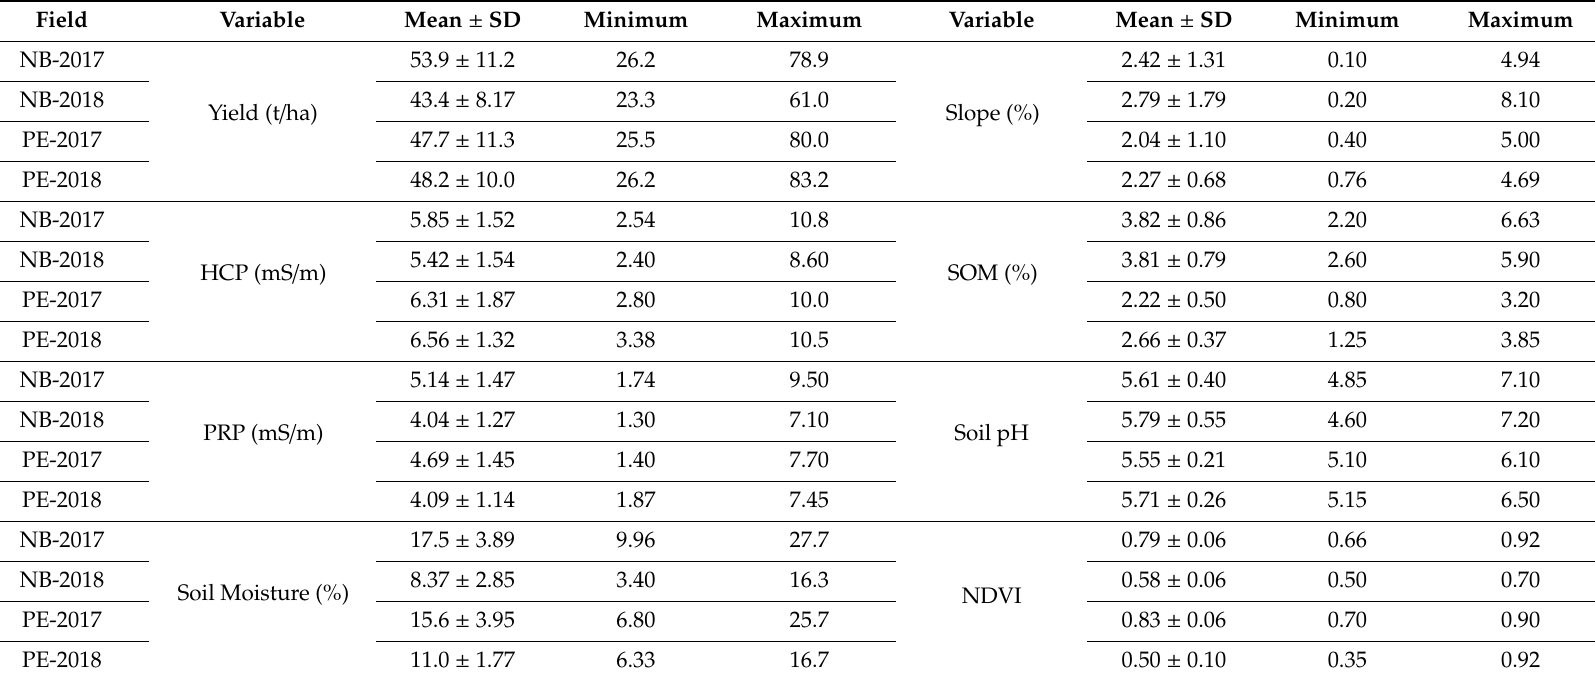
Table 3. Descriptive statistics of selected